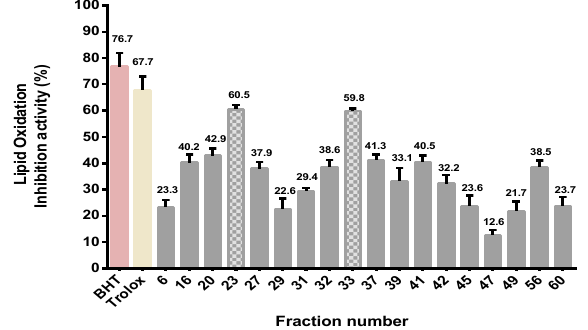
Figure 3 . Elution profile of EYUF-2 separated by gel permeation chromatography (GPC) on a Sephadex G-25 column. Separation of peptides was detected at 215 nm with flow rate of 1 mL/min.